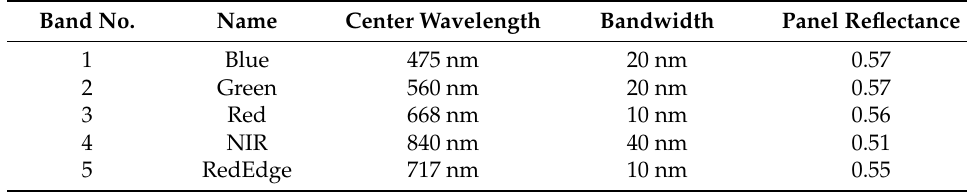
Table 2. Spectral information of the RedEdge camera. Band